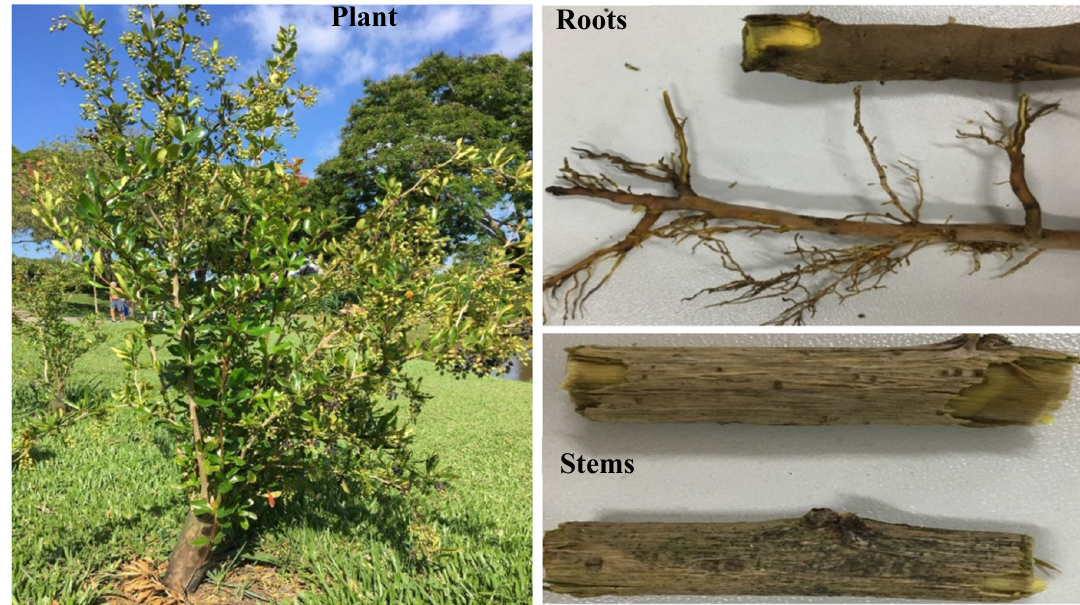
Figure 1. A representative specimen of Berberis laurina Billb. and its parts. The photos are available at http://www.ufrgs.br/fitoecologia/florars/open_sp.php?img=11160.